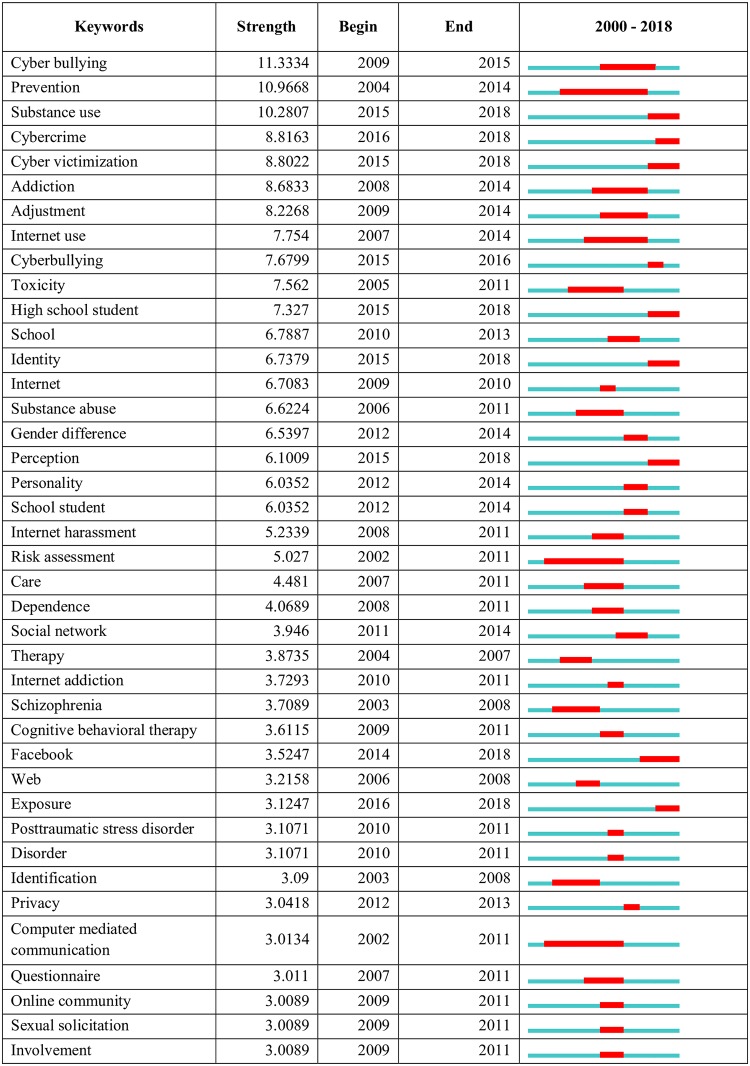
Top keyword bursts.